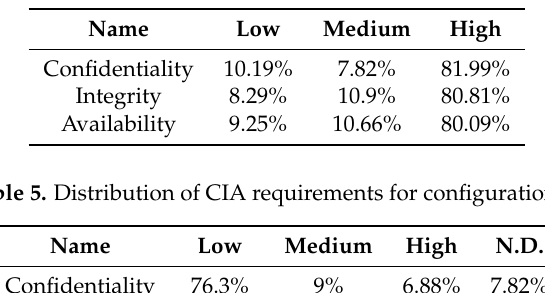
Table 4. Distribution of CIA requirements for configuration II.